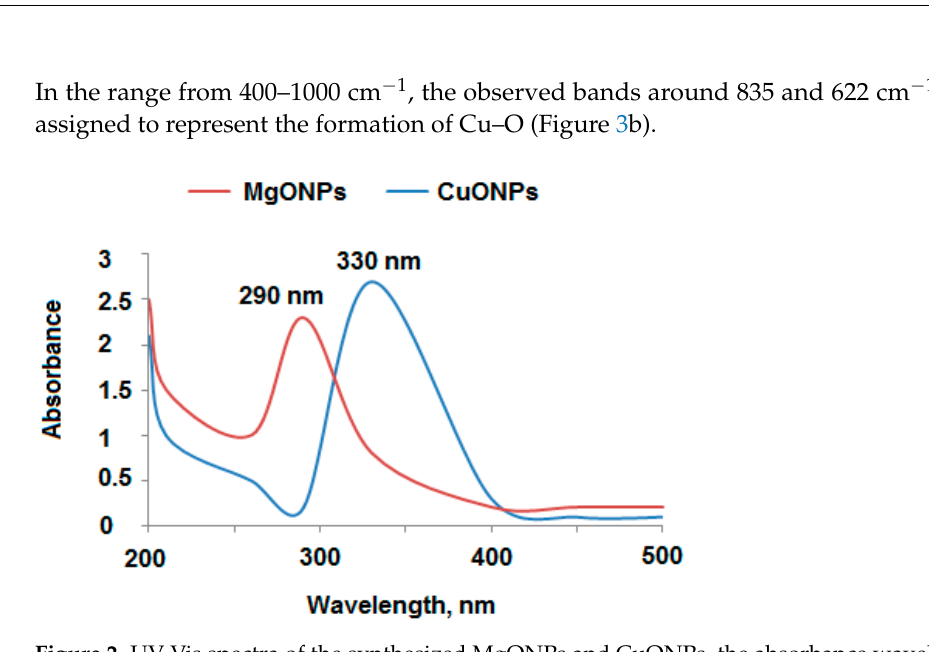
Figure 2. UV-Vis spectra of the synthesized MgONPs and CuONPs, the absorbance wavelength at 200–500 nm.